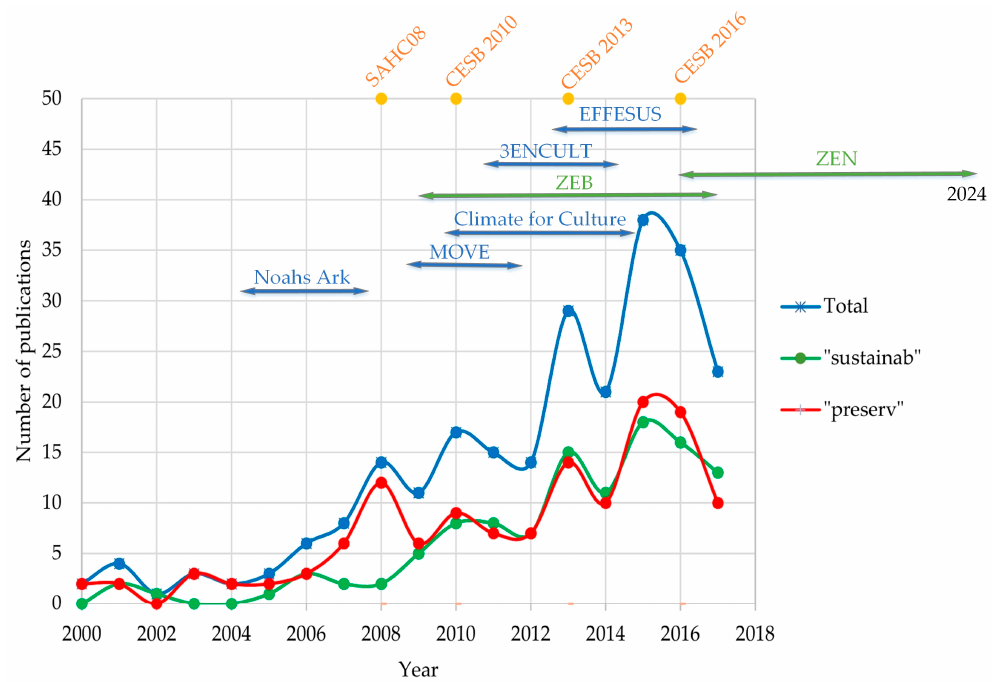
Figure 2. Distribution of documents by year of publication with indication of some major projects and conferences in the field that have influenced the growth of interest in this research topic. The Norwegian research centres for Zero-Emission Building (ZEB) and on Zero-Emission Neighbourhoods in Smart Cities (FME ZEN) are also highlighted.